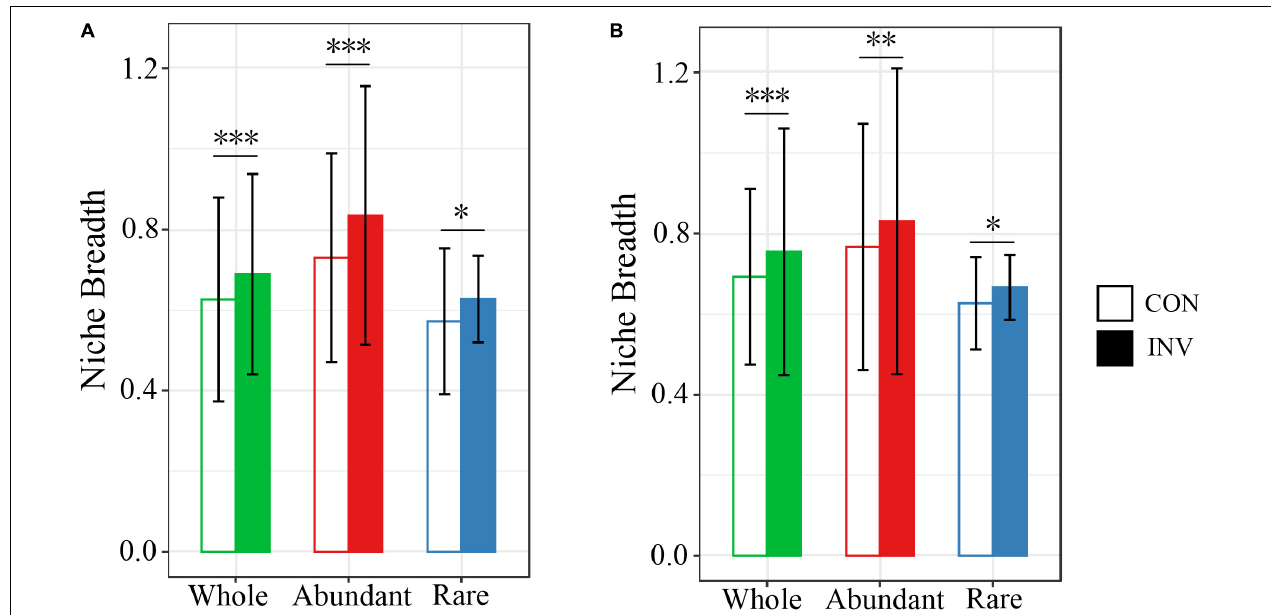
FIGURE 4 | Barplots showing the mean niche breadth for the whole, abundant, and rare bacterial communities of the B (A) and P (B) sediments. The significance level after evaluation through the nonparametric Mann-Whitney U test ( ∗ p < 0.05; ∗∗ p = 0.001; ∗∗∗ p < 0.001).